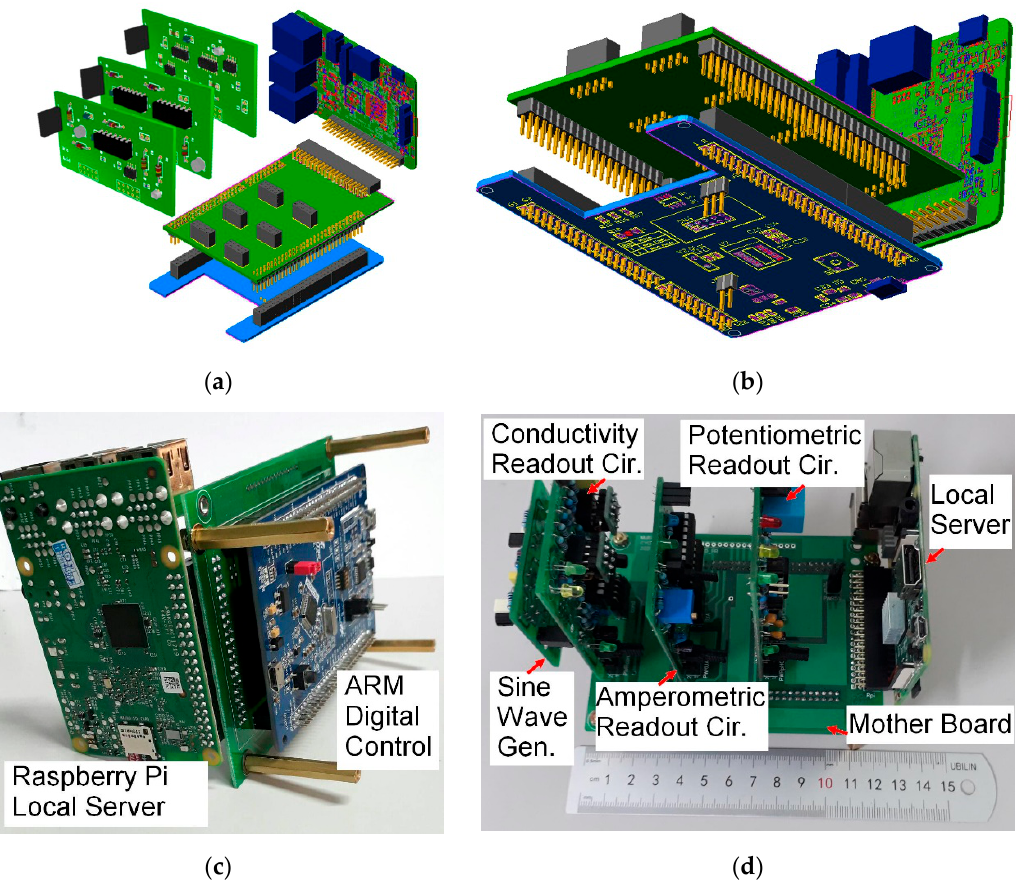
Figure 3. The system’s modular design. ( a ) 3D model of the top view; ( b ) 3D model of the bottom view; ( c ) bottom view of the on-board system; and ( d )top view of the on-board system.